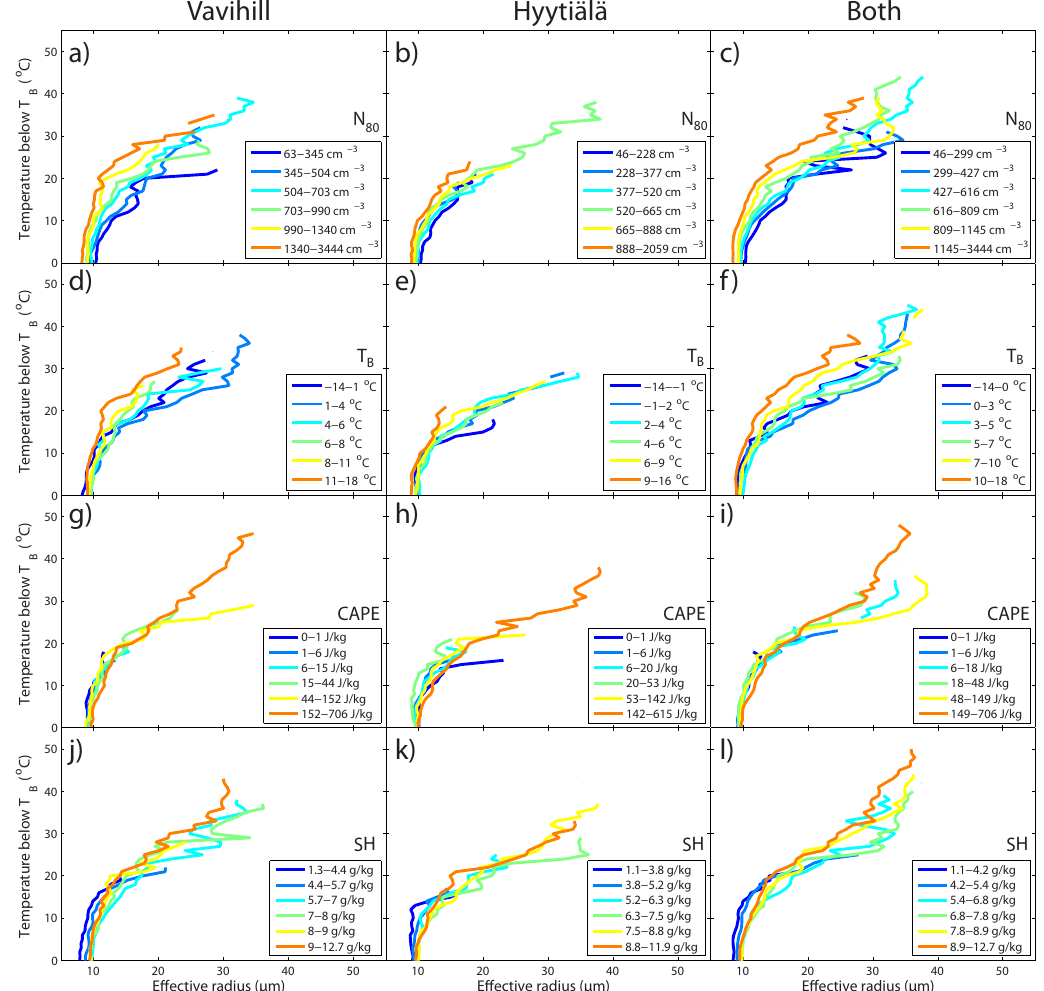
Fig. 4. Cloud effective radius is plotted as a function of temperature below that at cloud base to create vertical effective radius profiles. The figure shows average effective radius profiles for 6 percentiles of the data according to the N 80 (row 1), T B (row 2), CAPE (row 3) and SH (row 4). The profiles from Vavihill are shown in column 1, from Hyytiälä in column 2 and both datasets combined are shown in column 3. N 80 is the number concentration of particles with a diameter above 80nm, T B is the cloud base temperature, CAPE is the convective available potential energy and SH is the specific humidity at